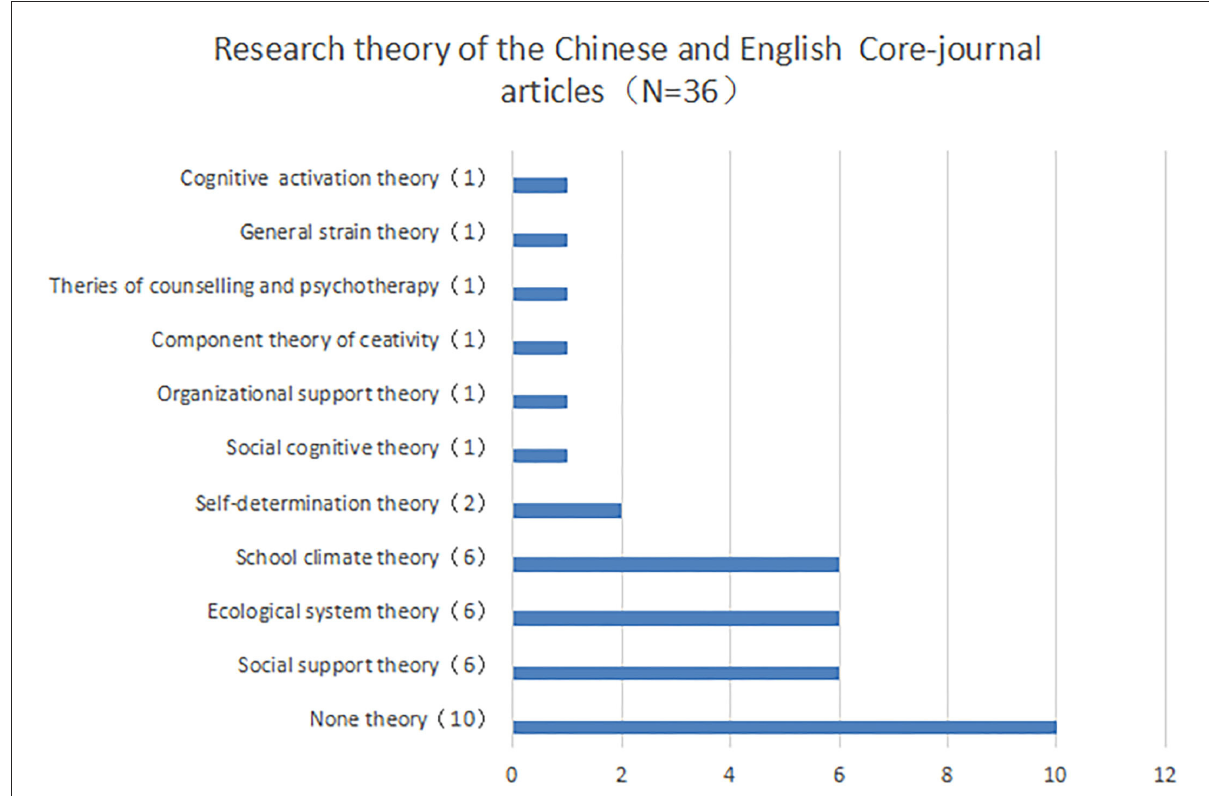
FIGURE3 Research theory of the Chinese and English core-journal articles (note: N = 36, it is the sum of seven Chinese core-journal articles and 29 English core-journal